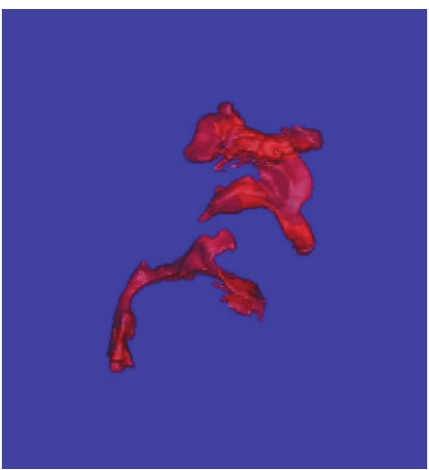
Figure 4: Three-dimensional computed tomography of the airway before surgery.